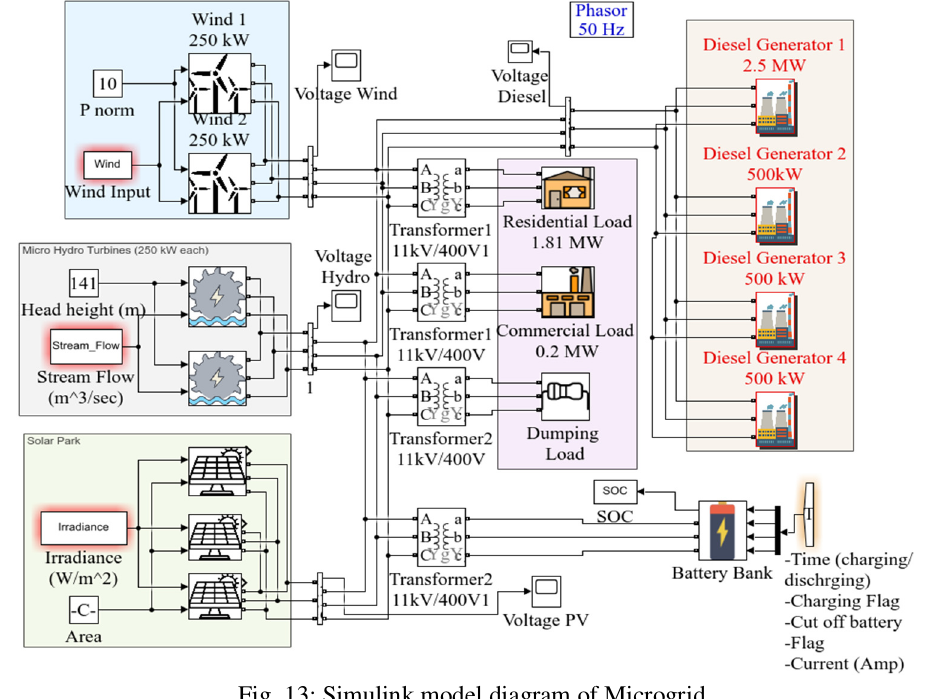
Fig. 13: Simulink model diagram of Microgrid